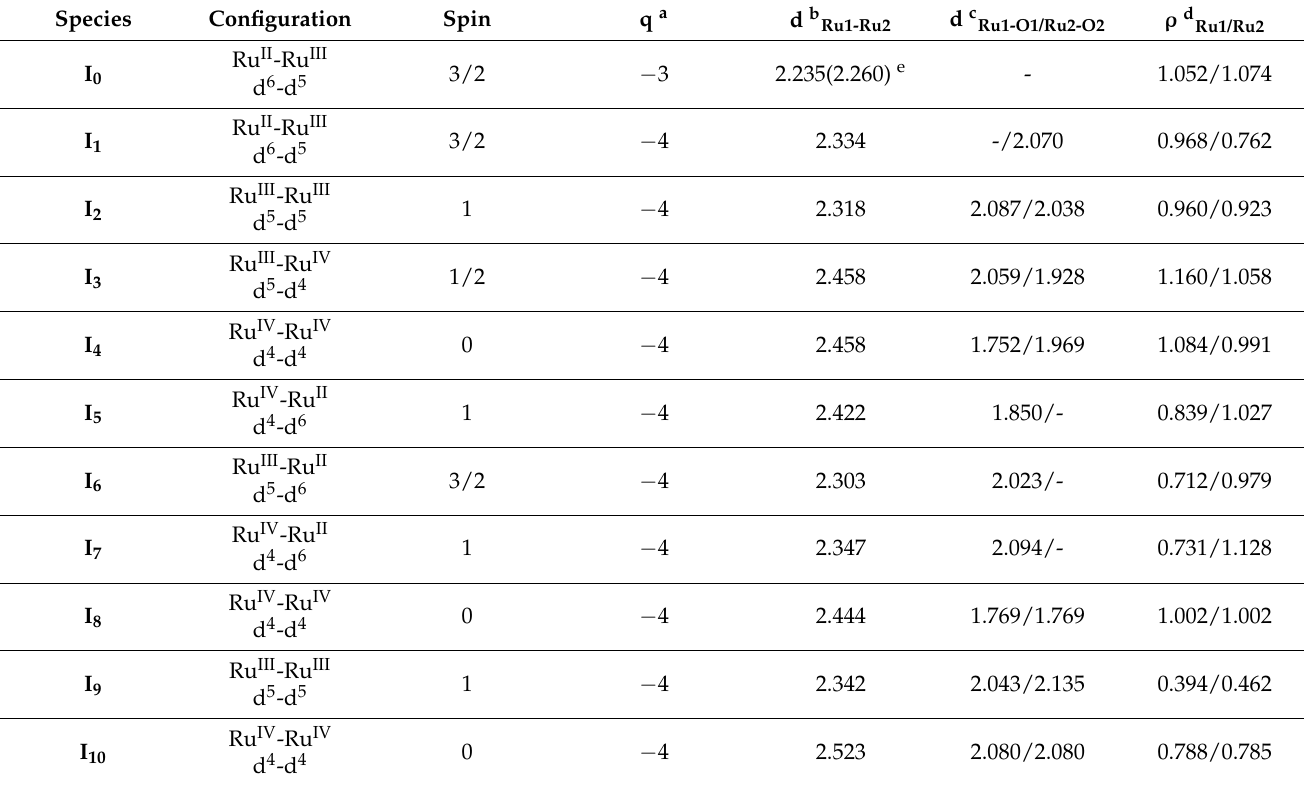
Table 1. Electronic and structural data for species involved in the water oxidation catalysts (WOC) mechanism.